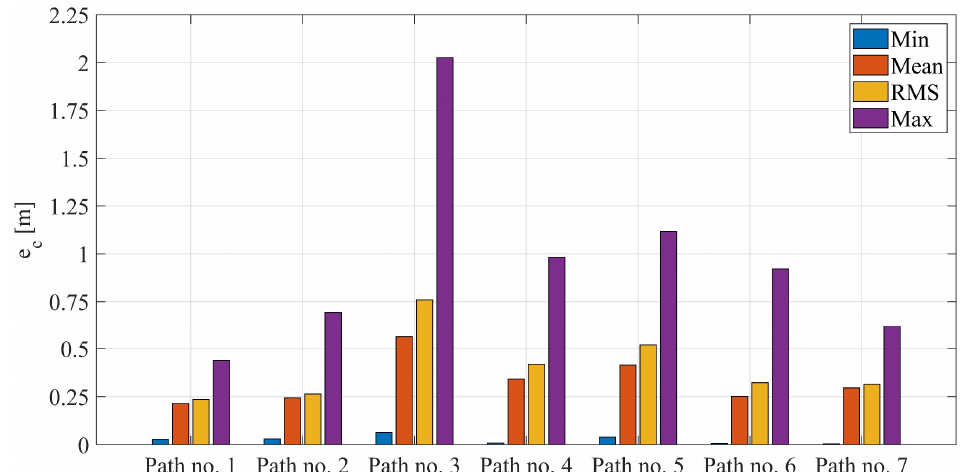
Figure 20. Basic descriptive statistics: minimum, mean, root mean square, and maximum of total errors for paths no. 1–7.